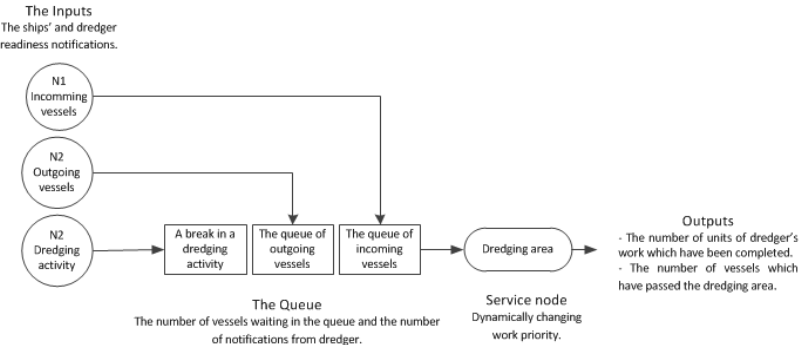
Figure 1. Service system module with relative priority during the conduct of dredging works in the port area. Source based on [46].